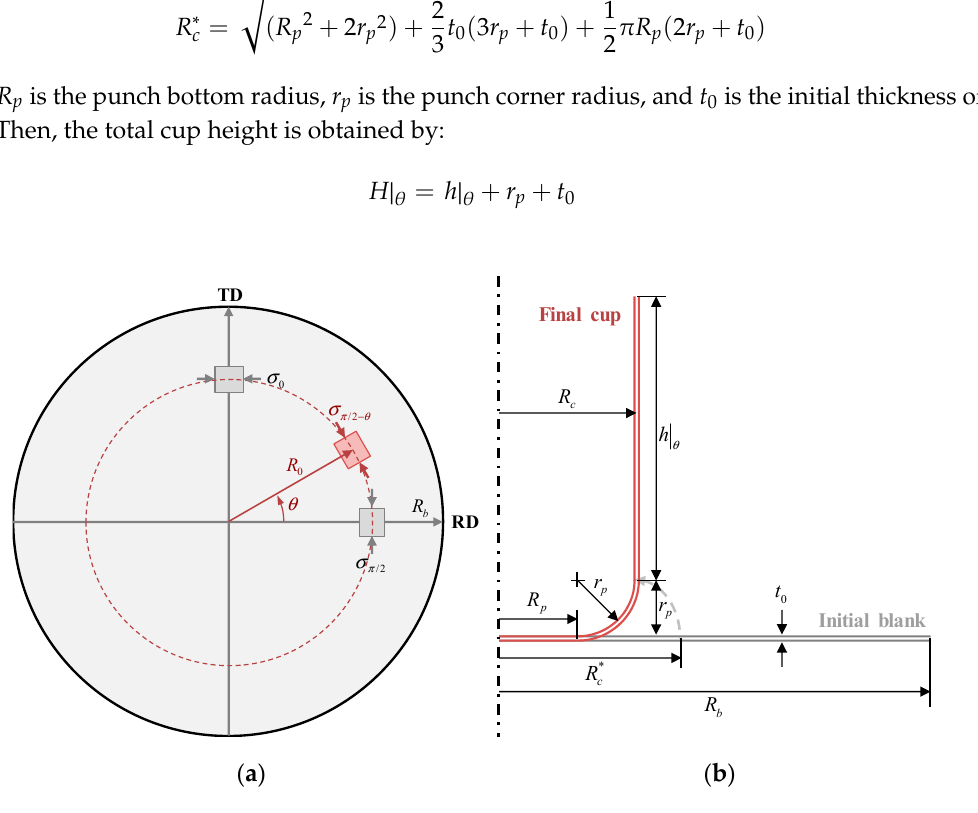
Figure 18. A schematic view of the initial circular blank and drawn cup: ( a ) top view of the initial blank and material element in the flange area; ( b ) cross-section view of the initial blank and the final cup.